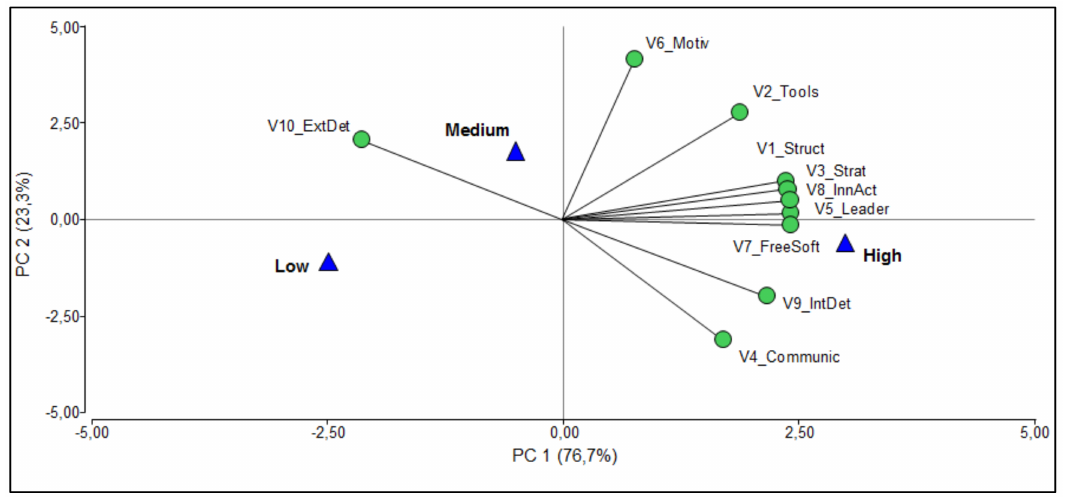
Figure 2. Biplot for the impact groups and each of the capability